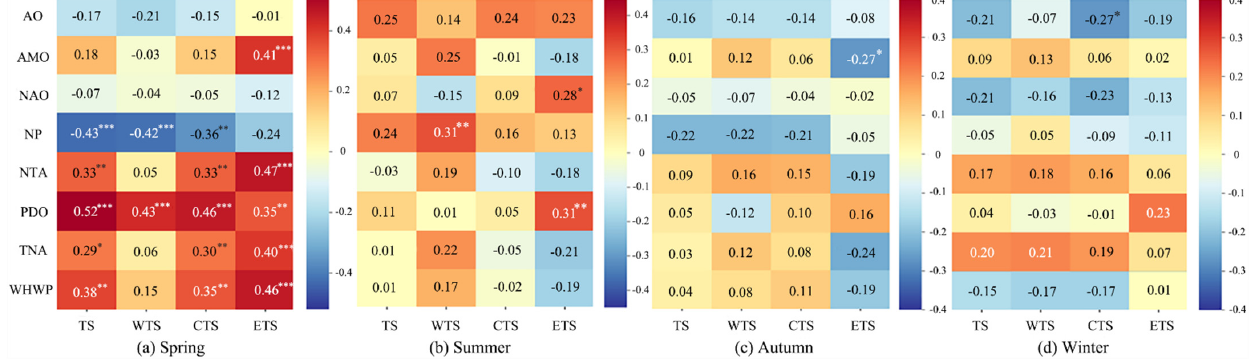
Figure 9. Correlation coefficients between precipitation and atmospheric circulation indexes in spring ( a ), summer ( b ), autumn ( c ), and winter ( d ): ***, **, and * represent significance at the level of 1%, 5%, and 10%, respectively.